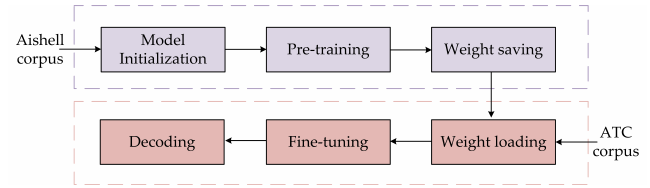
Figure 3. Transfer learning between different fields.